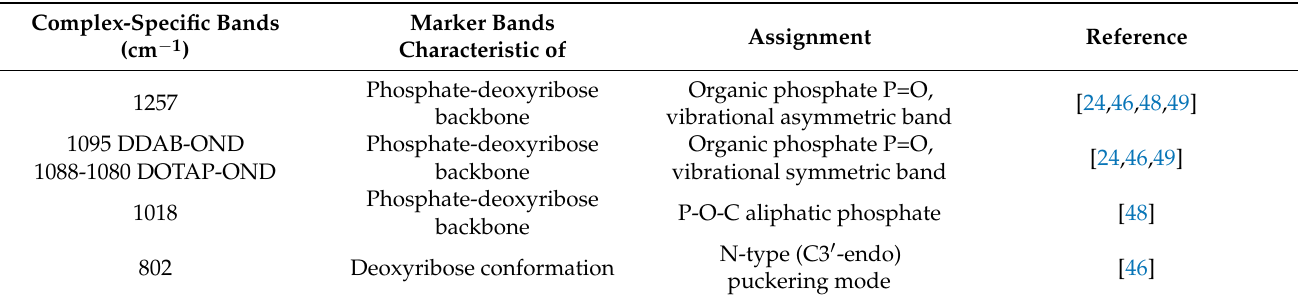
Table 5. Bands specific to the complexes of both cationic lipids and OND. Fourier-transform infrared (FTIR) spectra of the respective cationic lipid and OND were subtracted from the FTIR spectra of the complexes to obtain complex-specific bands. Bands were observed in the complexes at all ratios if not otherwise